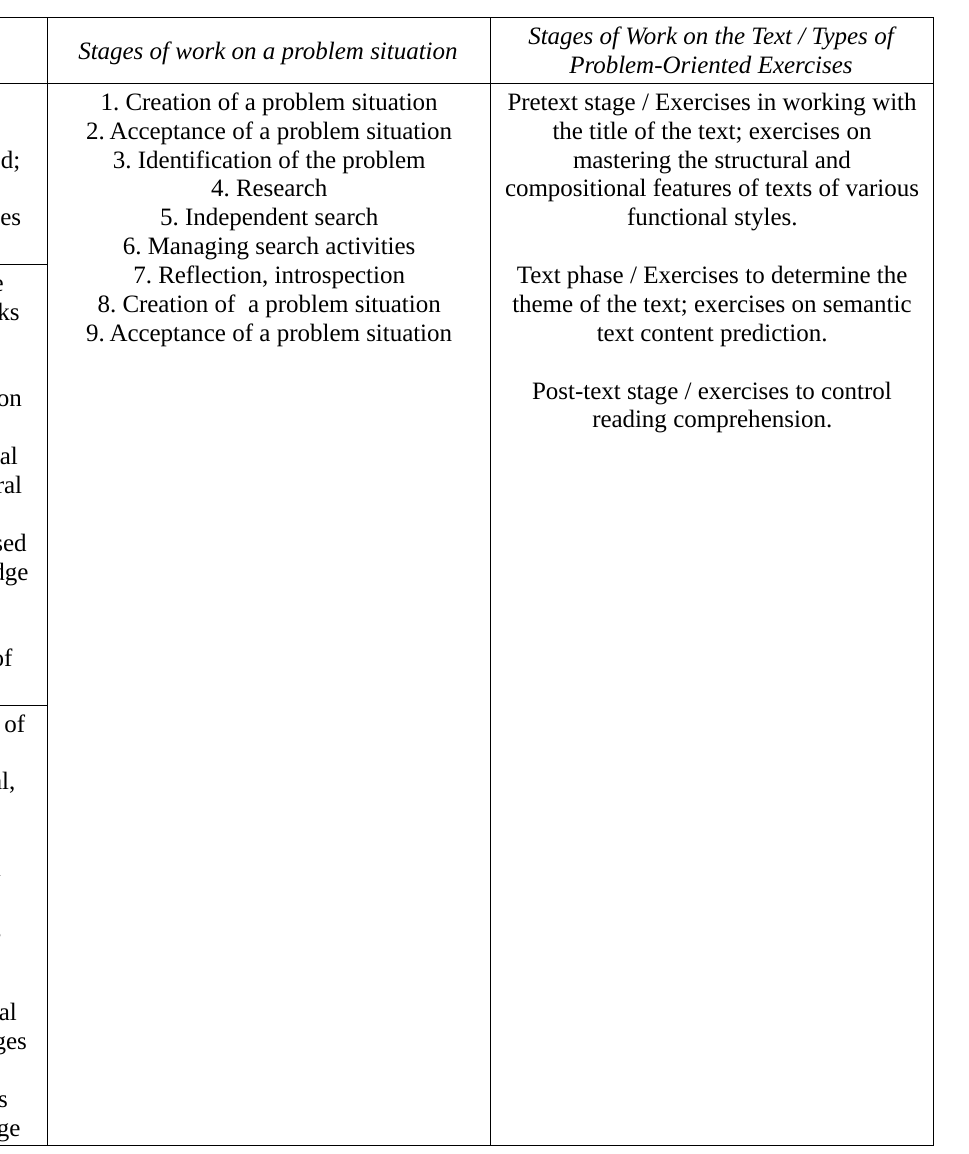
Table 3 - Model of Learning Monologue Speech Based on Reading Using the Technology of Problem-Based